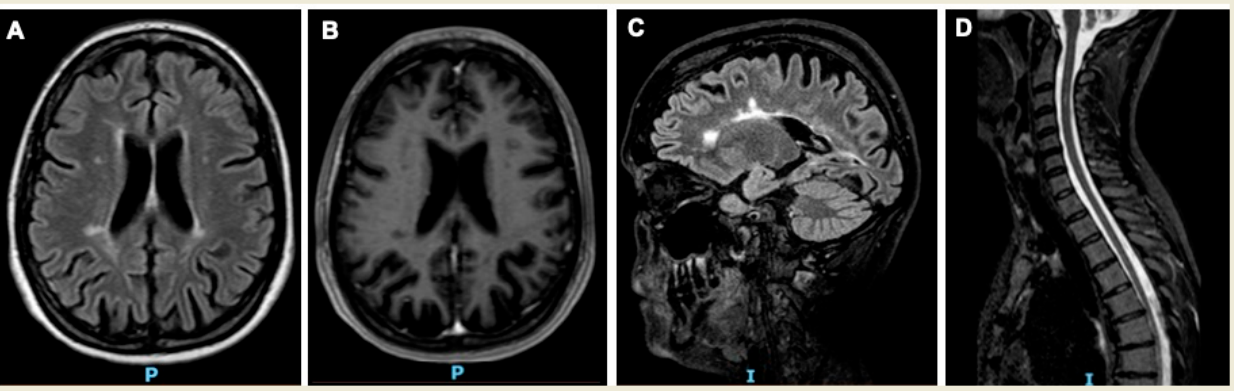
Figure 1. Brain and spine MRI at diagnosis of MS. Legend: the figure shows four MRI sequences ( A – D ). Explanation below. ( A ) Axial T2-weighted using a fluid attenuated inversion recovery (FLAIR), sequences of the brain MRI show typical periventricular hyperintense lesions due to the demyelination of the white matter. ( B ) The hyperintense lesions observed in sequence A appear hypointense in axial T1-weighted sequences of the brain MRI, due to axonal destruction and irreversible damage (also called “black holes”). ( C ) Sagittal T2-weighted using a fluid attenuated inversion recovery (FLAIR), sequences of the brain MRI show periventricular hyperintense lesions along the axis of the medullary veins, perpendicular to the body of the lateral ventricles and of the callosal junction (also called “Dawson’s fingers”). ( D ) Sagittal T2-weighted sequences of the spine MRI show a hyperintense demyelinating lesion at C3 level.